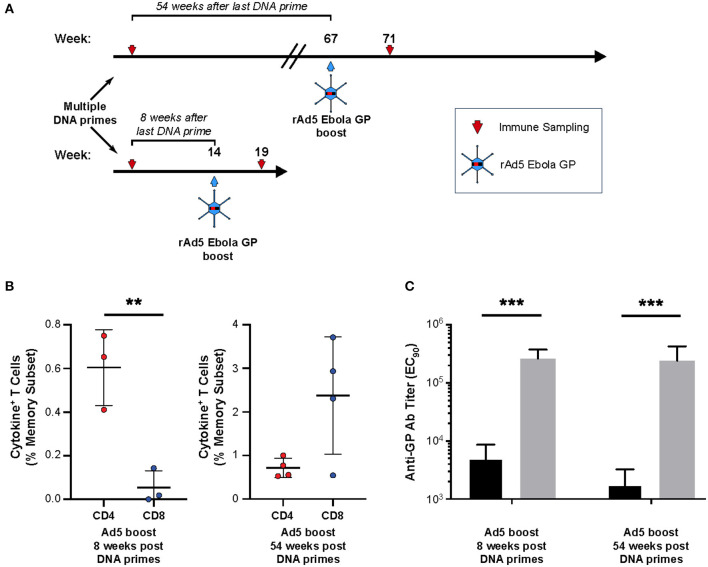
Effect of time interval between prime and boost on GP responses. (A) Study design: Four cynomolgus macaques were primed with multiple plasmids encoding Ebola GP(Z) and GP(S/G). Eight or 54 weeks after the last DNA immunization NHP's were boosted with 1011 PFU of rAd5-GP vaccine. Blood sampling for anti-GP antibody and T-cell analysis was taken before and after the rAd5 boost. (B) Antigen-specific CD4+ and CD8+ T-cells analyed 4 weeks after the boost in the short interval or 4 weeks after the boost in the long interval. (C) Anti-GP antibody titers, pre boost (black), post boost (gray). Statistical analysis between two groups was performed using an unpaired student's t-test; **p < 0.01, ***p < 0.001; mean ± standard deviation.